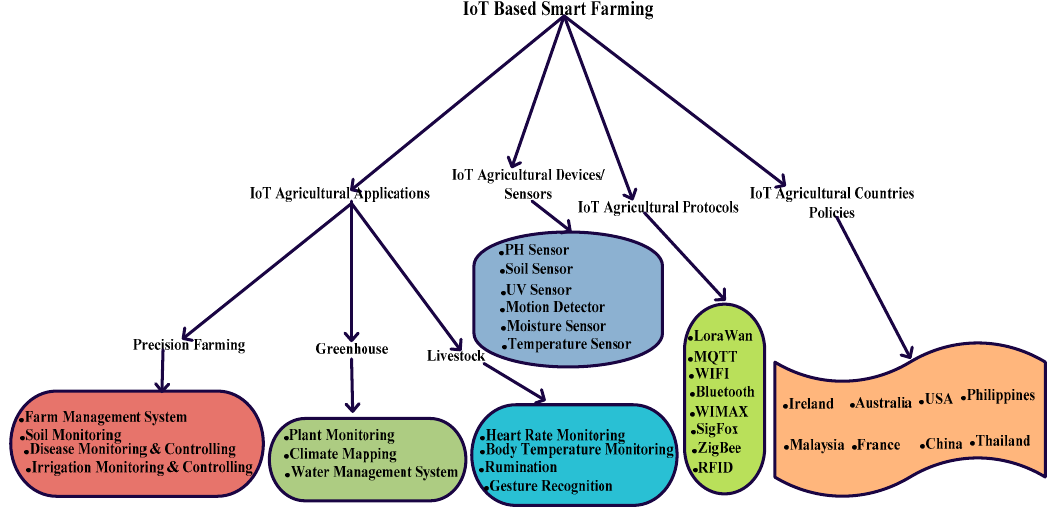
Figure 8. IoT agricultural hierarchy.